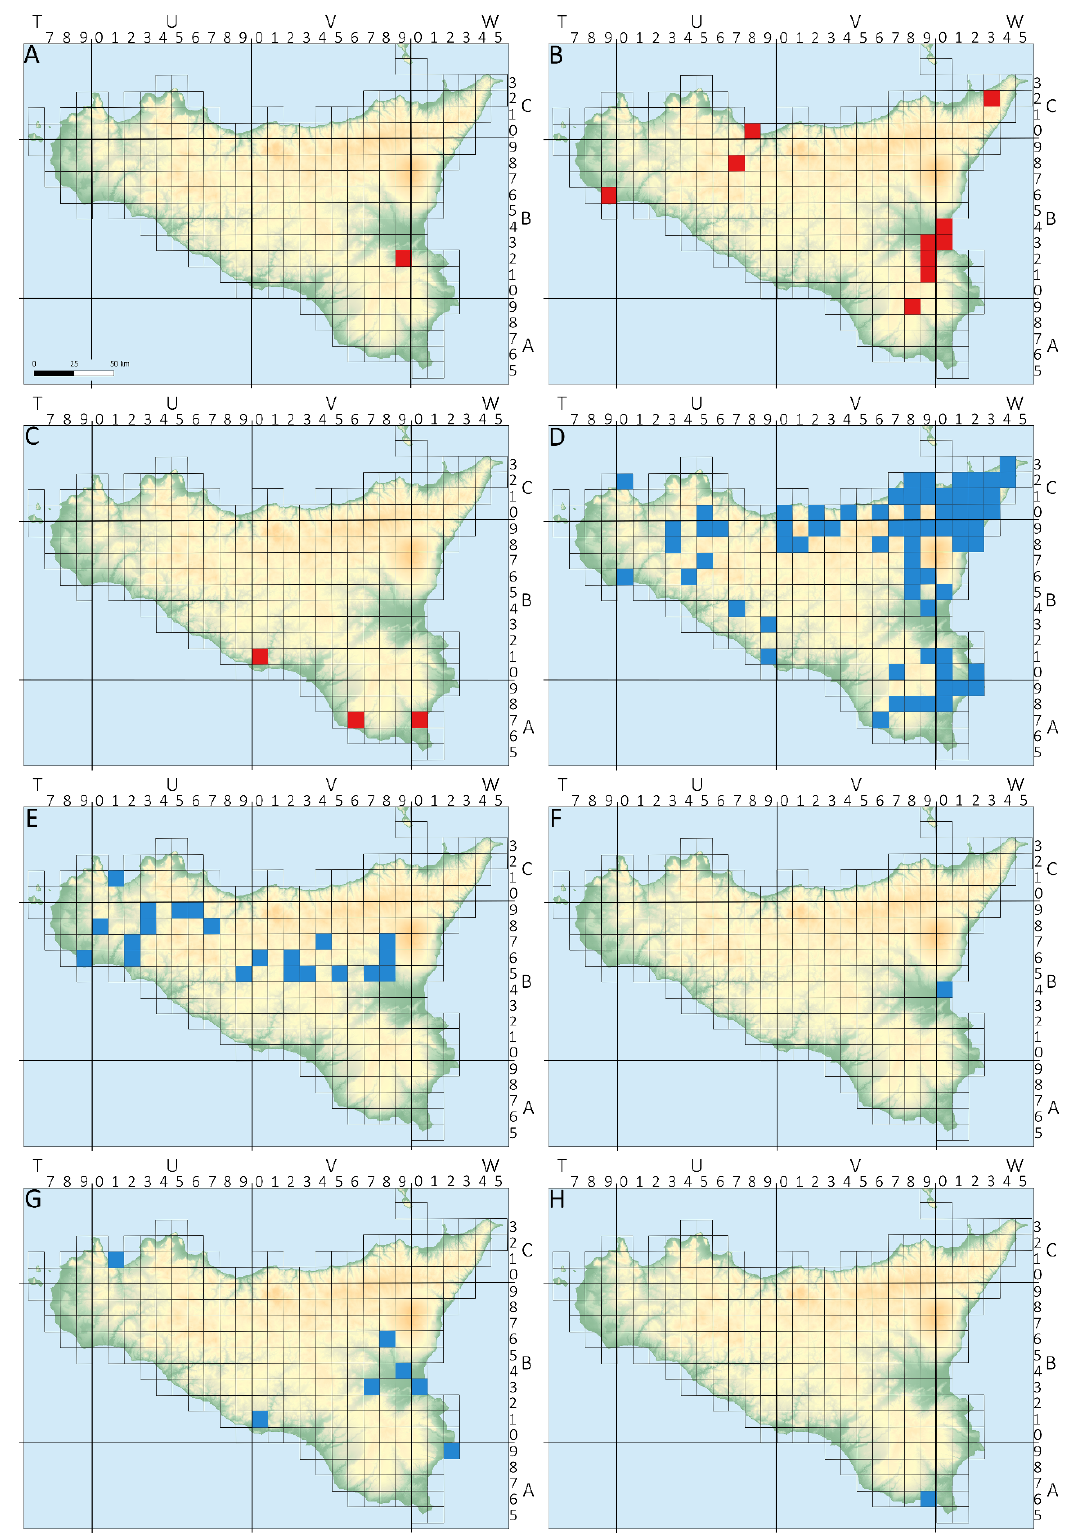
Figure 2. Occurrence sites of decapod species in Sicily. The blue squares represent the native species occurring in Sicily. Conversely, the red squares represent the alien ones. ( A ) Cherax destructor ; ( B ) Procambarus clarkii ; ( C ) Callinectes sapidus ; ( D ) Potamon fluviatile ; ( E ) Atyaephyra desmarestii ; ( F ) Palaemon adspersus ; ( G ) P. antennarius ; ( H ) P. elegans .